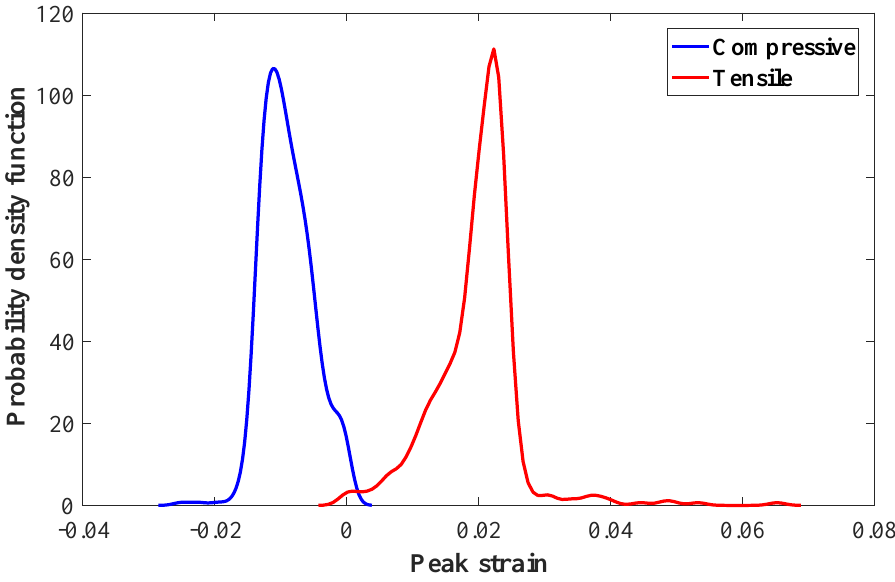
Figure 10. Probability density functions of the pipeline peak axial tensile strains and compressive strains generated for the location of